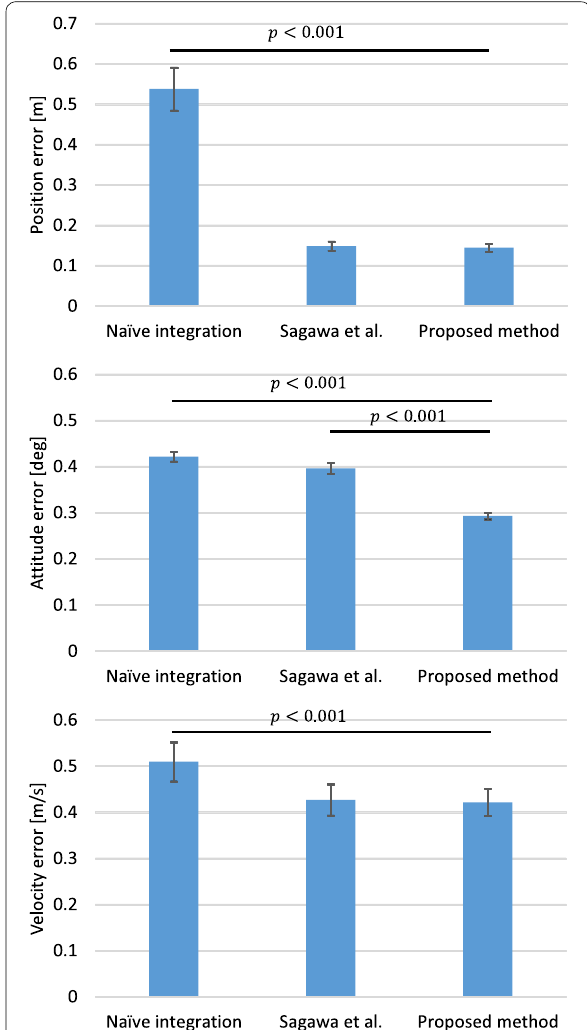
Fig. 11 Estimation errors using 1000 Hz simulated data